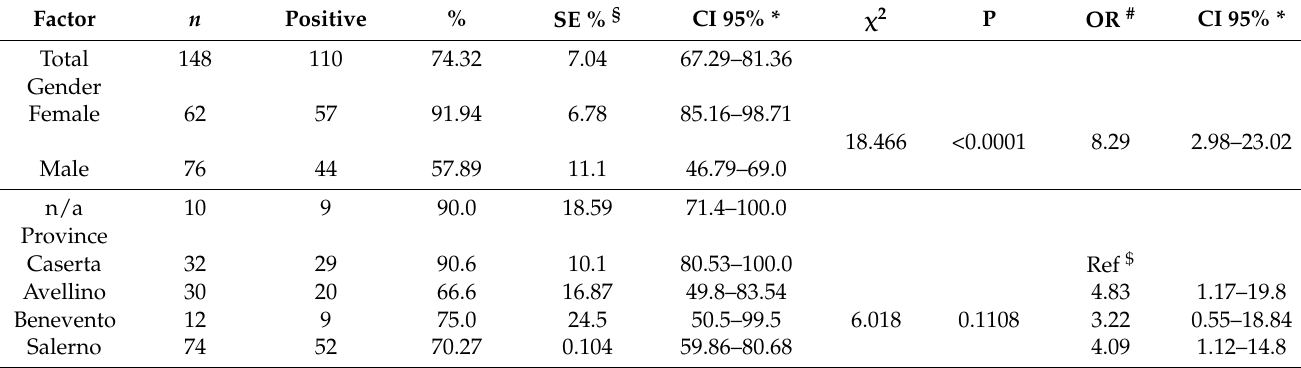
Figure 1. A map of the Campania (Italy) showing the distribution of samples of Eurasian wild boar ( Sus scrofa ) positive for porcine circoviruses. Apparent prevalences of PCV contact in the municipalities. Dot sizes are proportional to observed prevalences. Table 2. Molecular prevalence of infection with PCV-2 or PCV-3, and risk factor analysis by gender and location of wild boars in the Campania region as detected by real-time